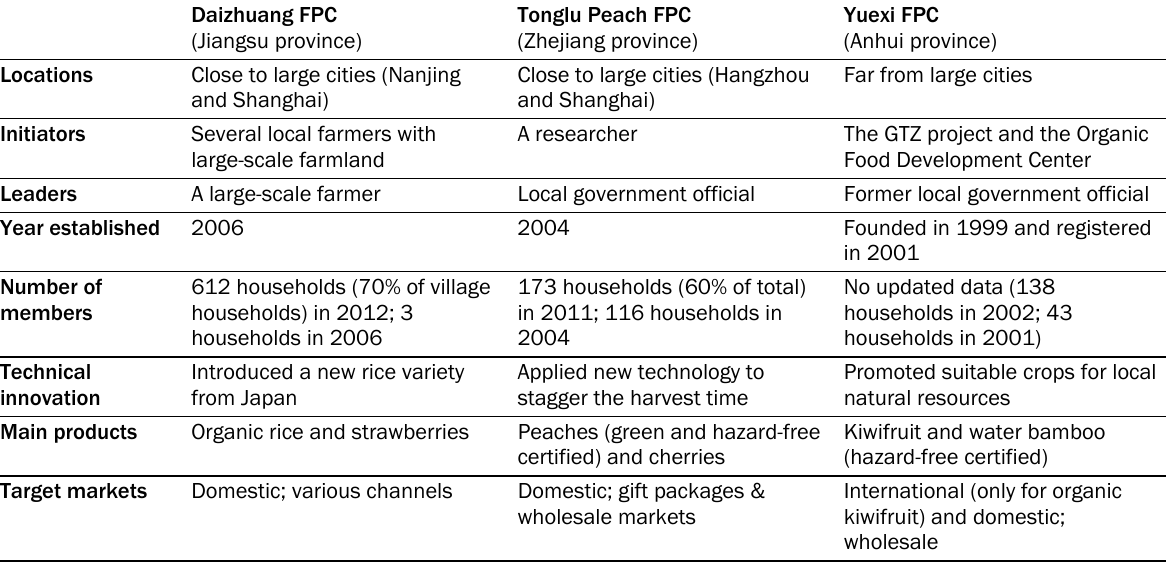
Table 2. Key Characteristics of Three Professional Farmers’ Cooperatives in China